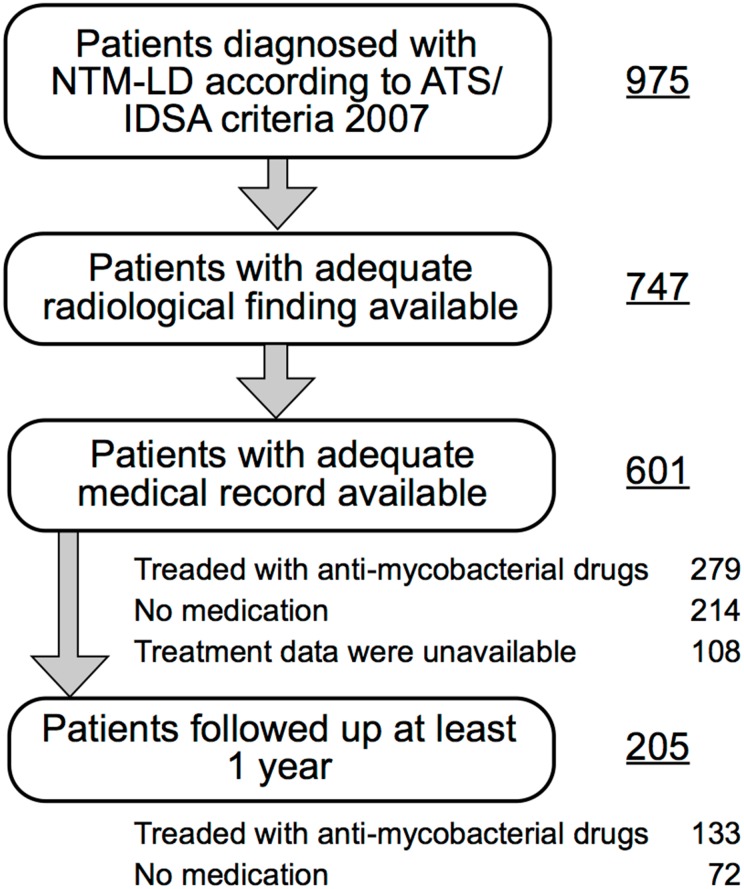
Flowchart of patient selection.